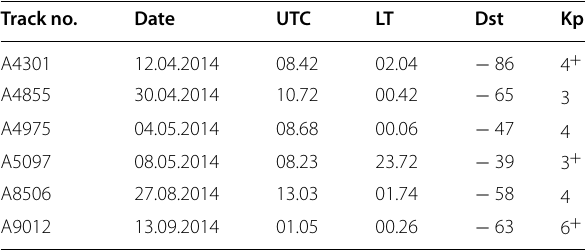
The coordinated universal time (UTC) and the local time (LT) are the respective times when Swarm A satellite passes the magnetic equator